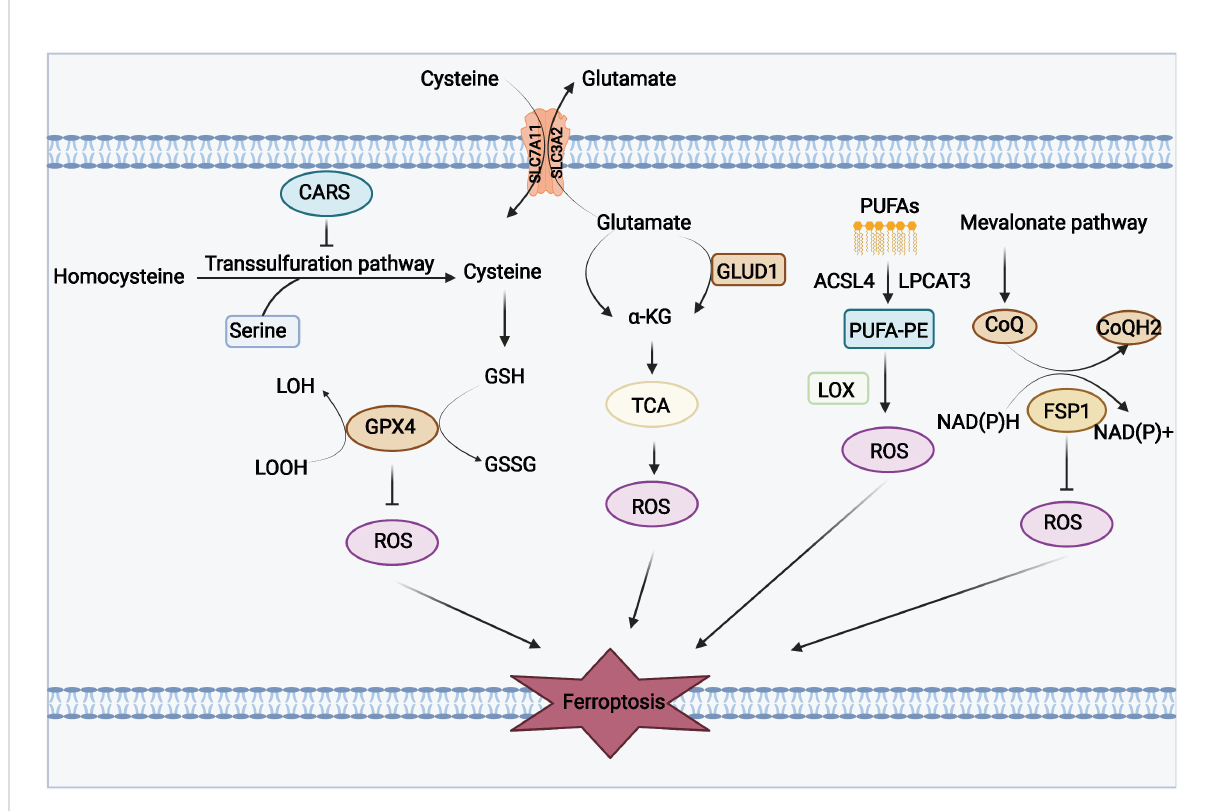
FIGURE 1 Mechanisms of amino acids and lipid metabolism in ferroptosis. Cysteine can be transported into the cell, whereas glutamate can be transported out of the cell by the Xc-system. Cysteine can be used to synthesize glutathione to maintain the balance of the redox state, and it can also be synthesized through the transsulfurization pathway blocked by CARS. Glutamate can be converted to a-KG by transaminase or GLUD1 pathway and participate in TCA, thereby generating ROS. PUFAs derived from cell membranes can be catalyzed by ACSL4 and LPCAT to PUFA-PE, and PUFA-PE can be peroxidized by the LOX family. FSP1 and coenzyme Q also play an important role in the antioxidant system of coenzyme